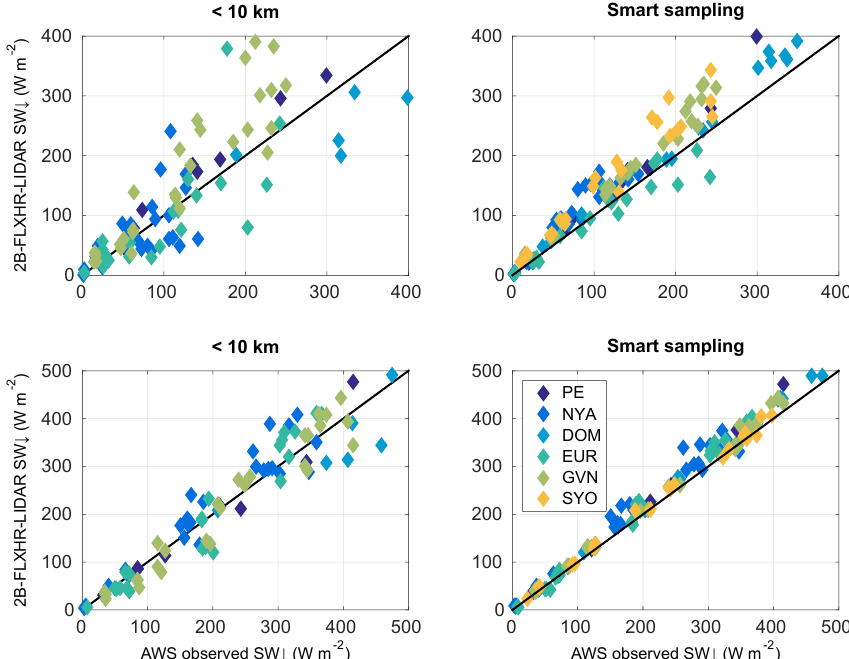
Figure 12. Monthly mean SW ↓ radiation comparison between 2B-FLXHR-LIDAR and AWS (2007–2010). Based on retrievals comprising of all satellite samples <10km from station, P10 ( r = 0 . 85) (upper left). Smart sampling approach, P10 ( r = 0 . 97) (upper right). Retrievals <10km from station, P90 ( r = 0 . 96) (lower left). Based on all satellite samples resulting from the smart sampling approach, P90 ( r = 0 . 99) (lower right).